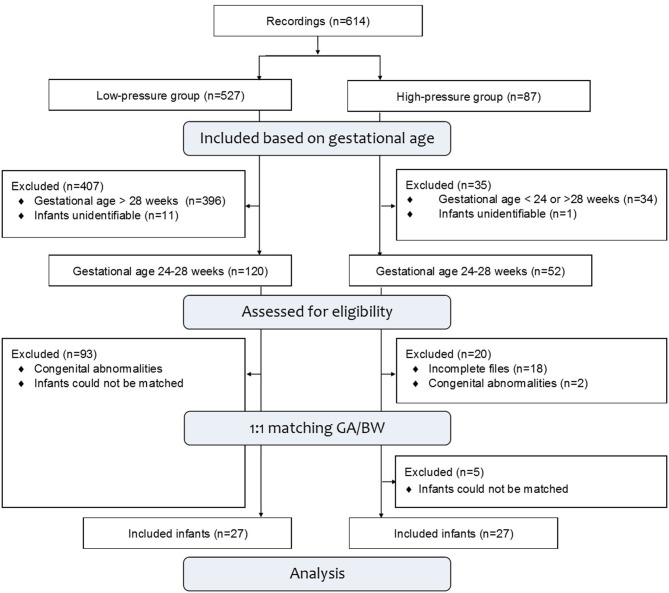
Study population. The LUMC and the University Hospital of Cologne stored 614 recordings, not including corrupt files. Recorded infants were assessed for eligibility and excluded based on gestational age, congenital abnormalities or unidentifiable video recordings. Infants who could not be matched were excluded as well as the remaining infants from the LUMC.